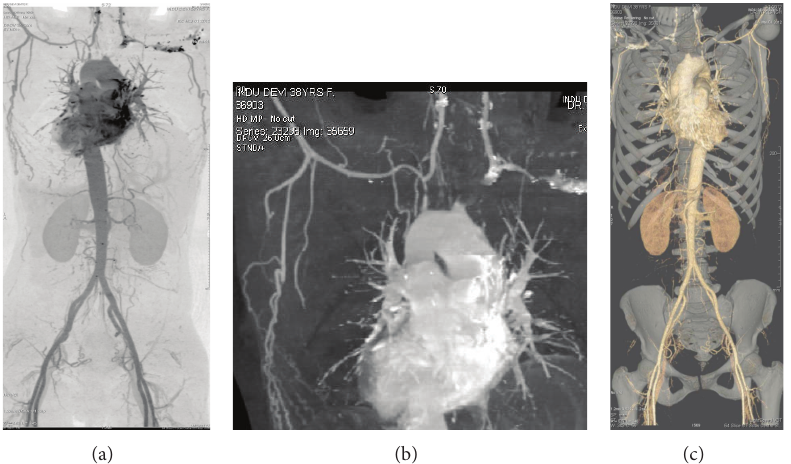
Figure 1: Narrowing of the origins of the great vessels with wall thickening and narrowing of great vessels for variable distance. Involvement of left subclavian artery > right subclavian artery. Involvement of right common carotid artery (CCA) > left CCA. Involvement of thoracic aorta. F/S/O Takayasu’s